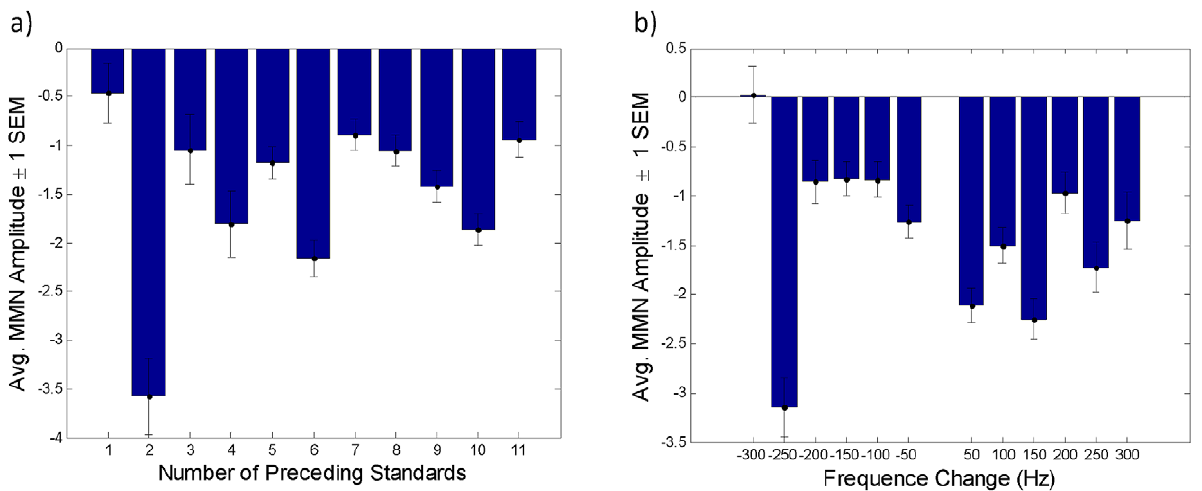
Figure 6. Trends in MMN amplitudes. Figure 6a shows the average MMN amplitude as a function of the number of standards preceding the deviant. Figure 6b shows the average MMN amplitude as a function of the frequency of the deviant minus the frequency of the preceding standard (frequency change).